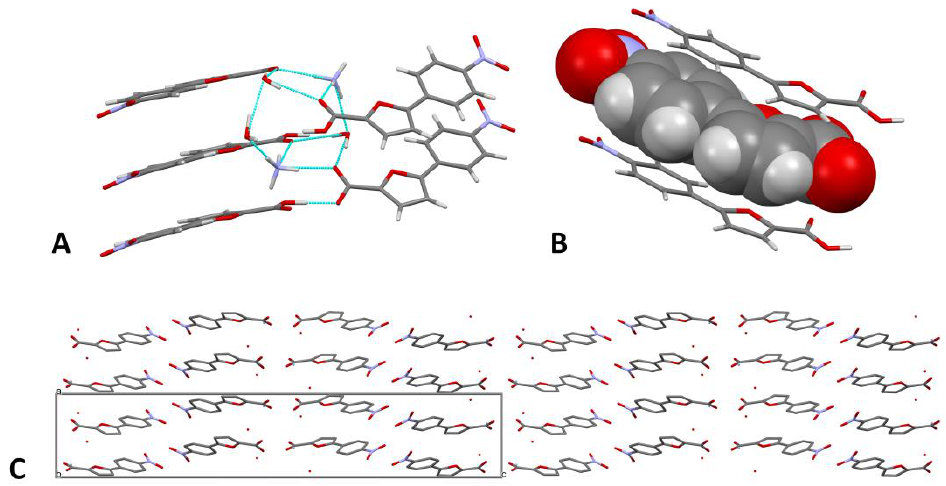
Figure 2. ( A ). Simplified graphical representation of the H-bond network. ( B ). Stick-spacefilling model showing the π - π stacking interactions between the molecules. ( C ). Crystal packing viewed along the b axis. Hydrogen atoms are omitted for the sake of clarity. Table 1. H-bond geometry (D: Donor, A: Acceptor), as calculated by PARST [26].